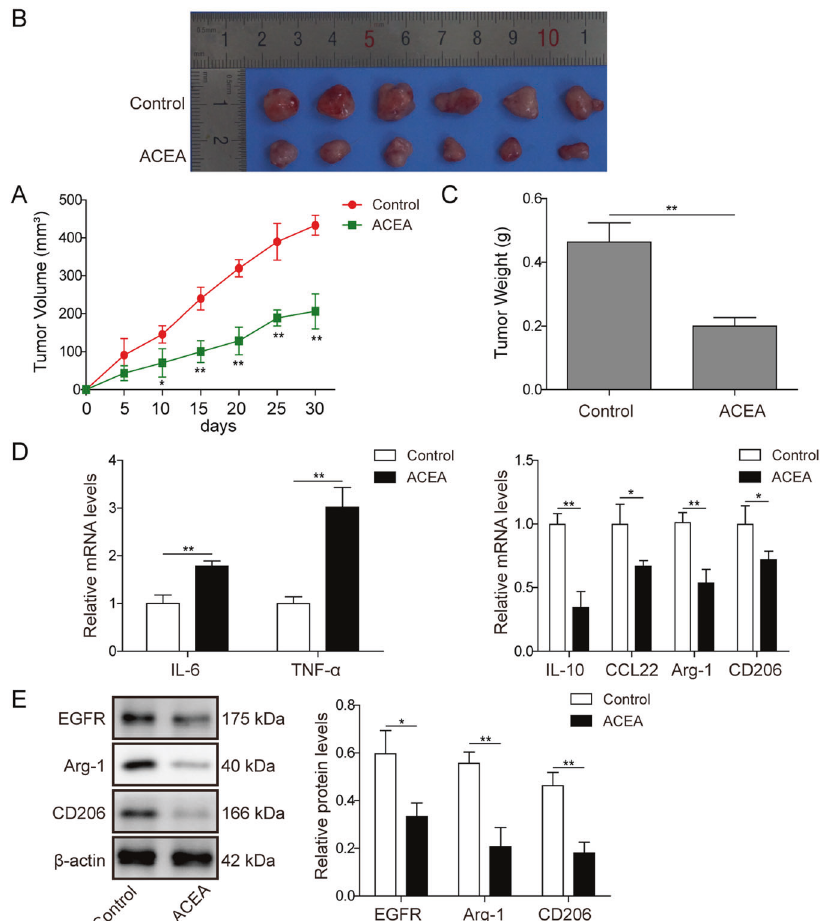
Fig. 7 CB1 activation suppressed tumorigenesis in vivo. SW480 cells were subcutaneously injected into nude mice and the tumors were treated with control or ACEA (1.5 mg/kg/d). A CB1 activation suppressed tumor growth. Representative tumors ( B ) and tumor weight ( C ) from different experimental groups. D QPCR analysis showed that CB1 activation increased the expression of IL-6 and TNF- α , and decreased the expression of IL-10, CCL-22, Arg-1 and CD206. E Western blot analysis showed that the expression of EGFR, Arg-1 and CD206 were decreased in the tumors of ACEA-treated mice. * P < 0.05; ** P <